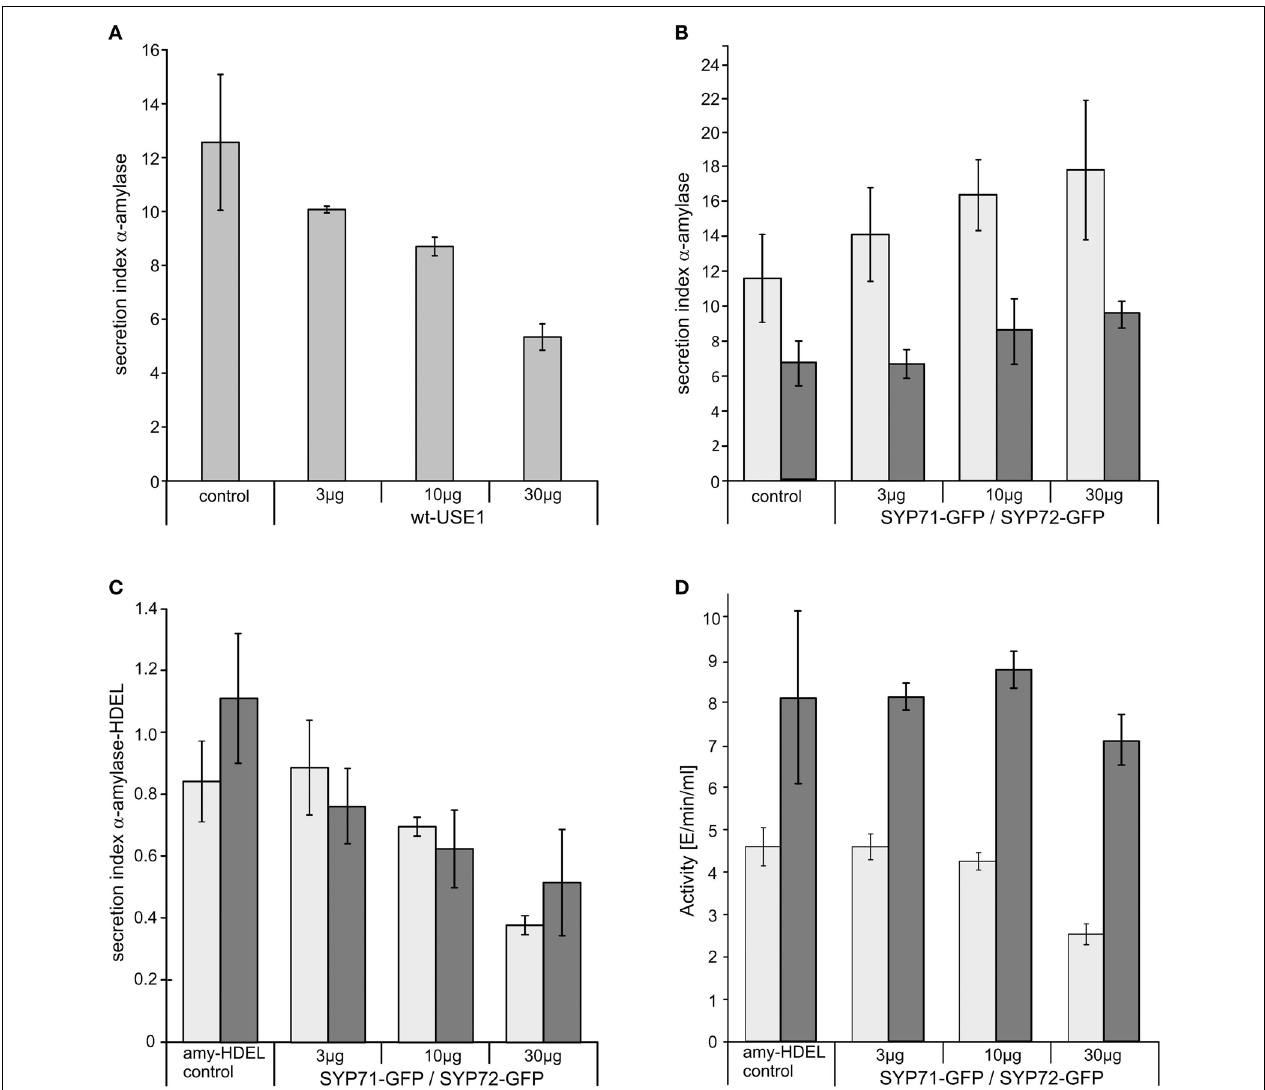
secretion index calculated as described in Materials and Methods.The first column shows as a control the expression of the reporter alone, the other columns the coexpression with constructs in different concentrations as indicated below the axis. USE1 inhibits secretion (A) while SYP71, SYP72 do not (B) . Expression of either SYP71-GFP or SYP72-GFP lowers the secretions index of α -amylase-HDEL indicating a more efficient retrograde Golgi-ER transport (C) .Total activity for SYP71-GFP [ (D) light gray] or SYP72-GFP [ (D) dark gray] decreased only at very high amounts of electroporated DNA. Standard deviations are given as vertical lines in each